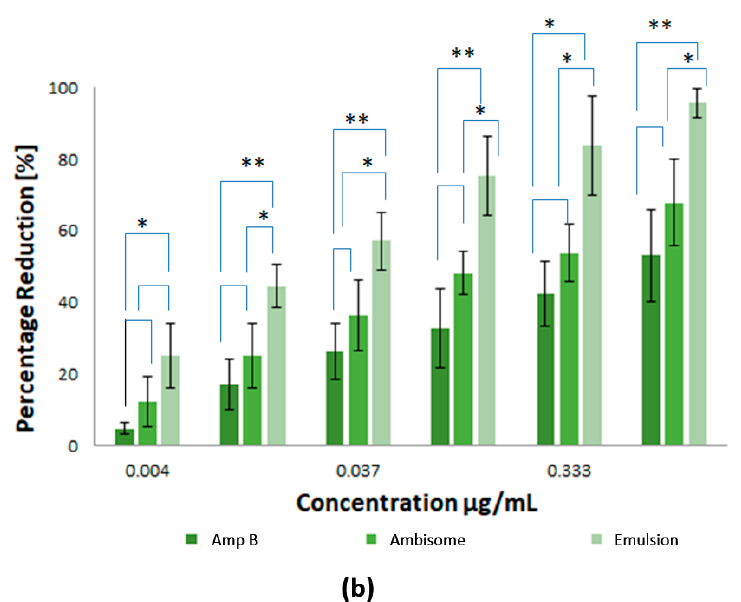
Figure 7. Pharmacological evaluation of the anti-leishmanial activities of the polymeric nanoparticles where different concentrations of nanoformulations were utilized: ( a ) inhibition of L. tropica KWH23 amastigotes at various concentrations and ( b ) inhibition of L. donovani amastigotes at various concentrations. Results are presented as mean ± SD of four experiments and were analyzed by paired t test and with a significance threshold denoted by p values set at * = p < 0.05 and ** = p < 0.01.